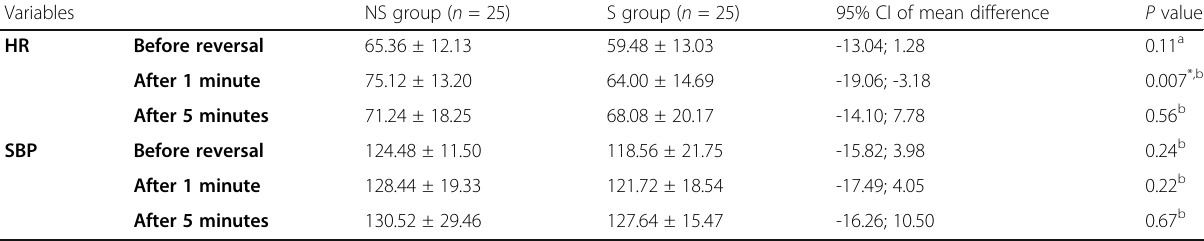
Table 5 Hemodynamic comparison before and after administration of reversal: HR&SBP Variables